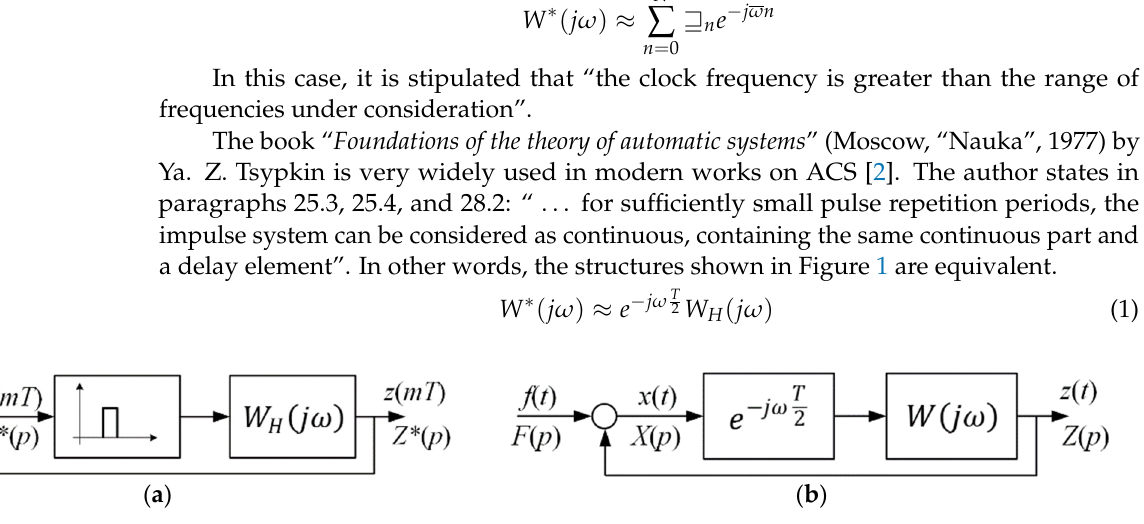
Figure 1. Structural diagrams of an impulse ACS ( a ) and a continuous ACS with a “delay” link ( b ).